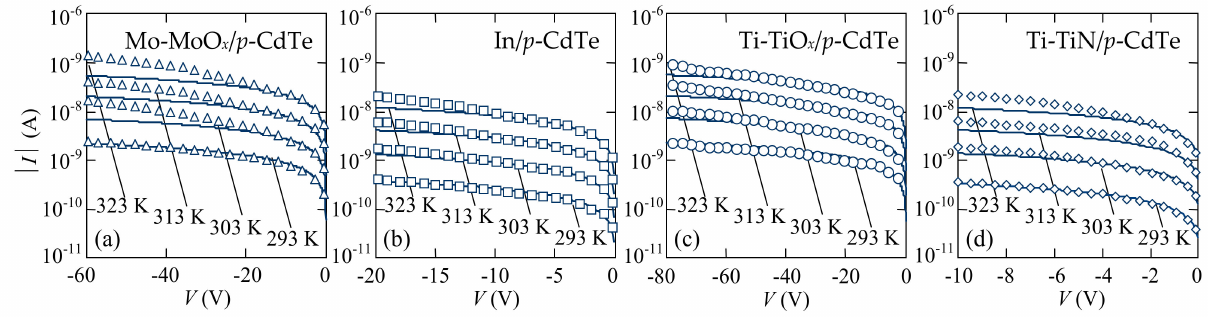
Figure 5. Comparison of the experimental data (symbols) and results calculated according to the Sah–Noyce–Shockley theory (solid lines) of the reverse I-V characteristics of the ( a ) Mo-MoO x / p -CdTe/MoO x -Mo, ( b ) In/ p -CdTe/MoO x -Mo, ( c ) Ti-TiO x / p -CdTe/MoO x -Mo, and ( d ) Ti-TiN/ p -CdTe/MoO x -Mo Schottky-diode detectors at different